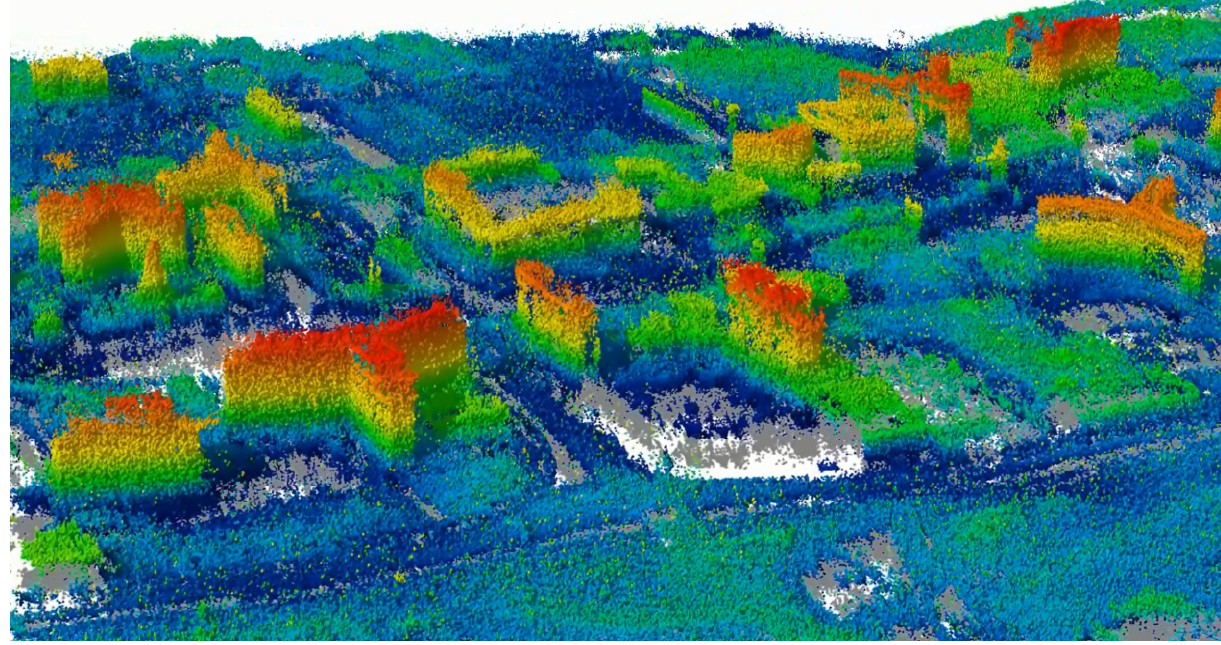
Figure.1. 3-D view of the scatterers reconstructed by TomoSAR reconstruction of city blocks in downtown Las Vegas, using a stack of 30 images acquired by TerraSAR-X. Height is